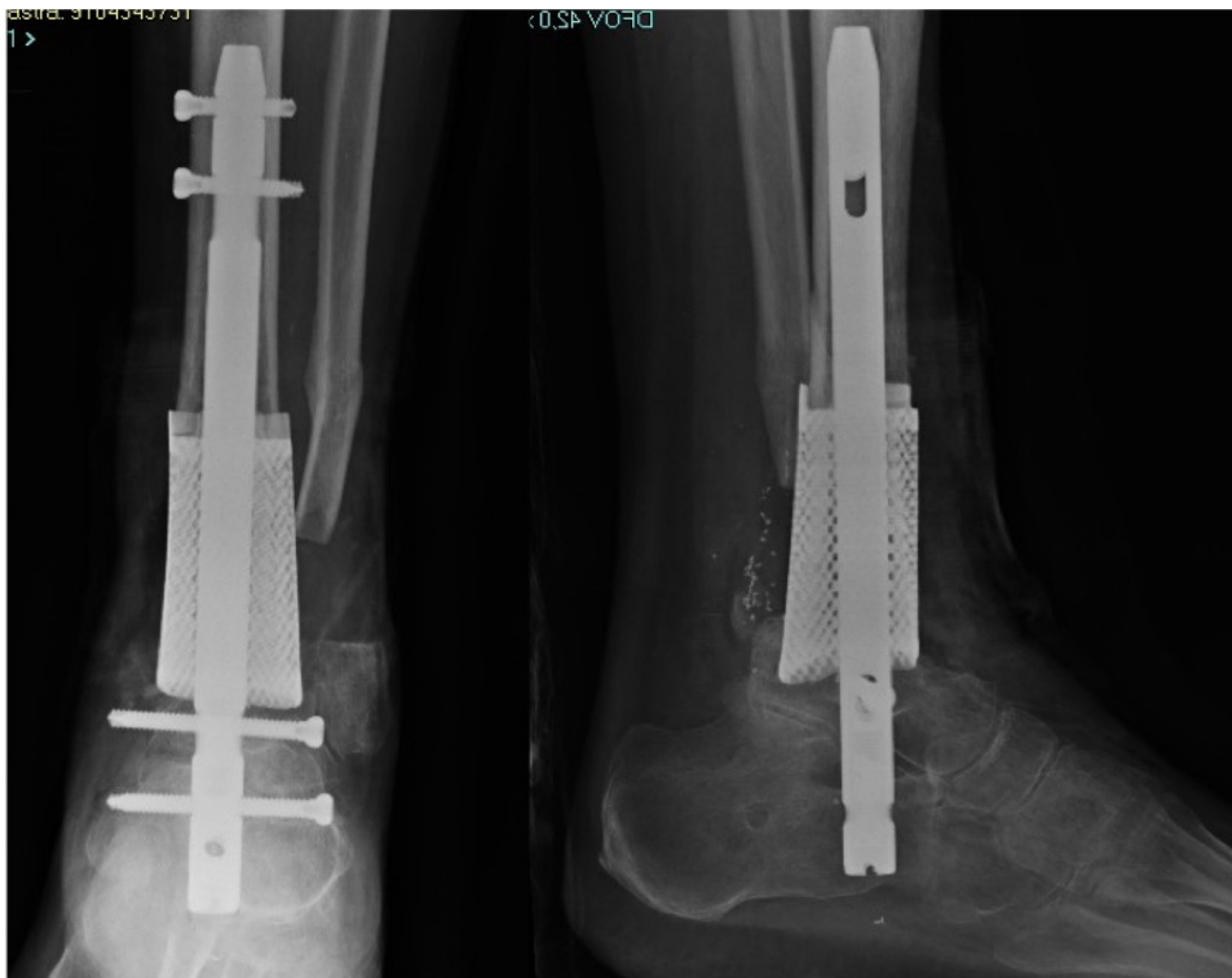
Figure 4. Post-operative X-ray of the final custom-made construct.